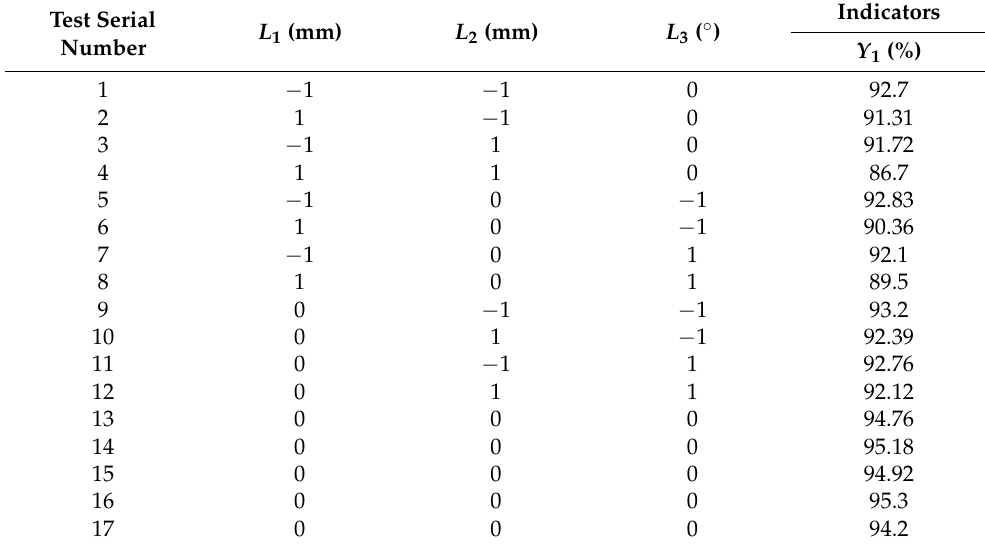
Table 3. Simulation test scheme and results.